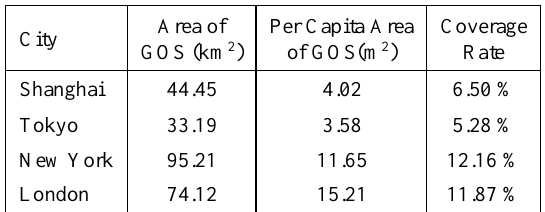
Table 4. The per capita area and coverage rate of